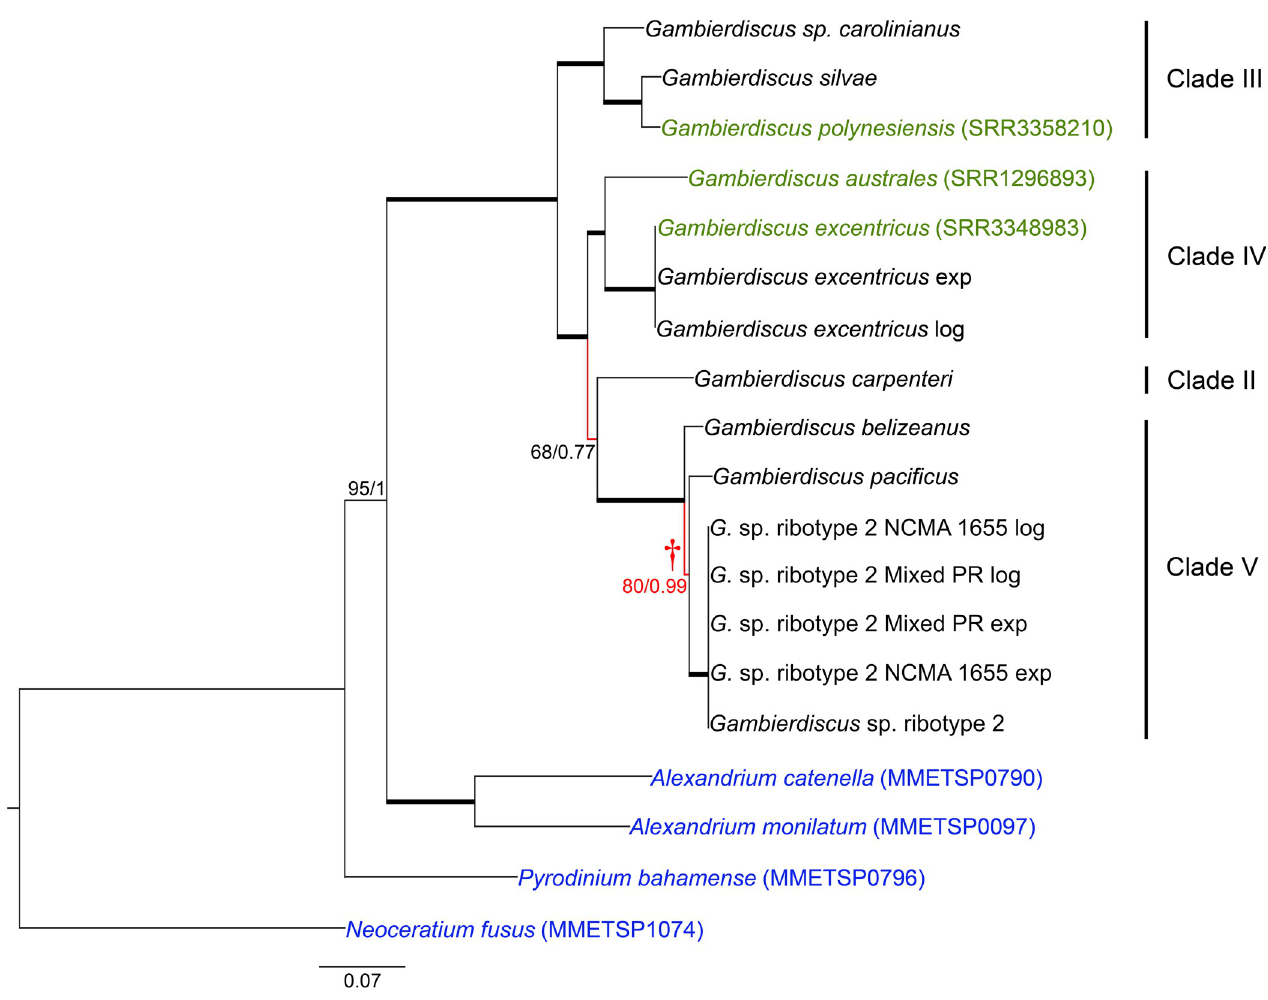
Fig 4. Phylogenetic tree of Gambierdiscus using transcriptomes and Janousˇkovec et al ., 2017 reference genes. Maximum likelihood tree (found by RAxML), supported by Bayesian analysis. Branches indicated in red are not supported (ML bootstrap � 80%; Bayesian posterior probability < 1). Taxa in green indicate Gambierdiscus transcriptomes obtained from NCBI. Taxa in blue indicate outgroups, whose transcriptomes were also obtained from NCBI. SRA identifiers are found in parentheses next to the taxon name. Branch with low support (†) indicates a possible single common ancestor of G . belizeanus , G . pacificus , and G . sp. ribotype 2. Genes were chosen using the genes described in Janousˇkovec et al ., 2017 as reference. Nucleotide tree: 17 genes; 22,743 bp. There are 0.07 substitutions per